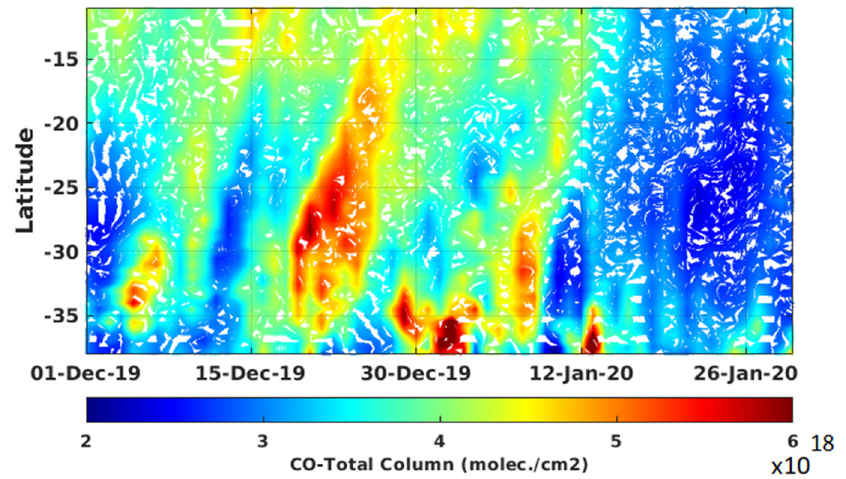
Figure 2. Hovmöller diagram of the total column of CO obtained from IASI observations over